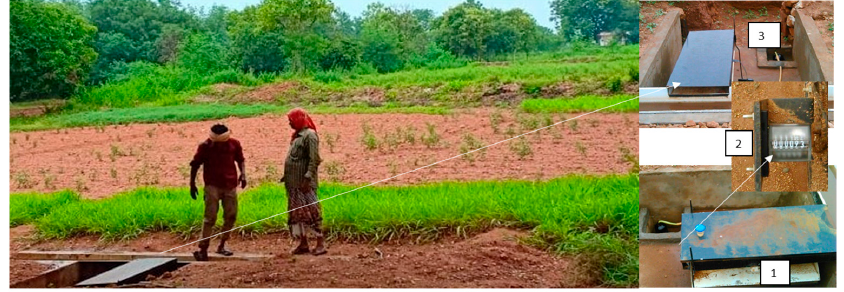
Figure 2. Tipping bucket device used for measuring soil loss in all of the treatment plots.